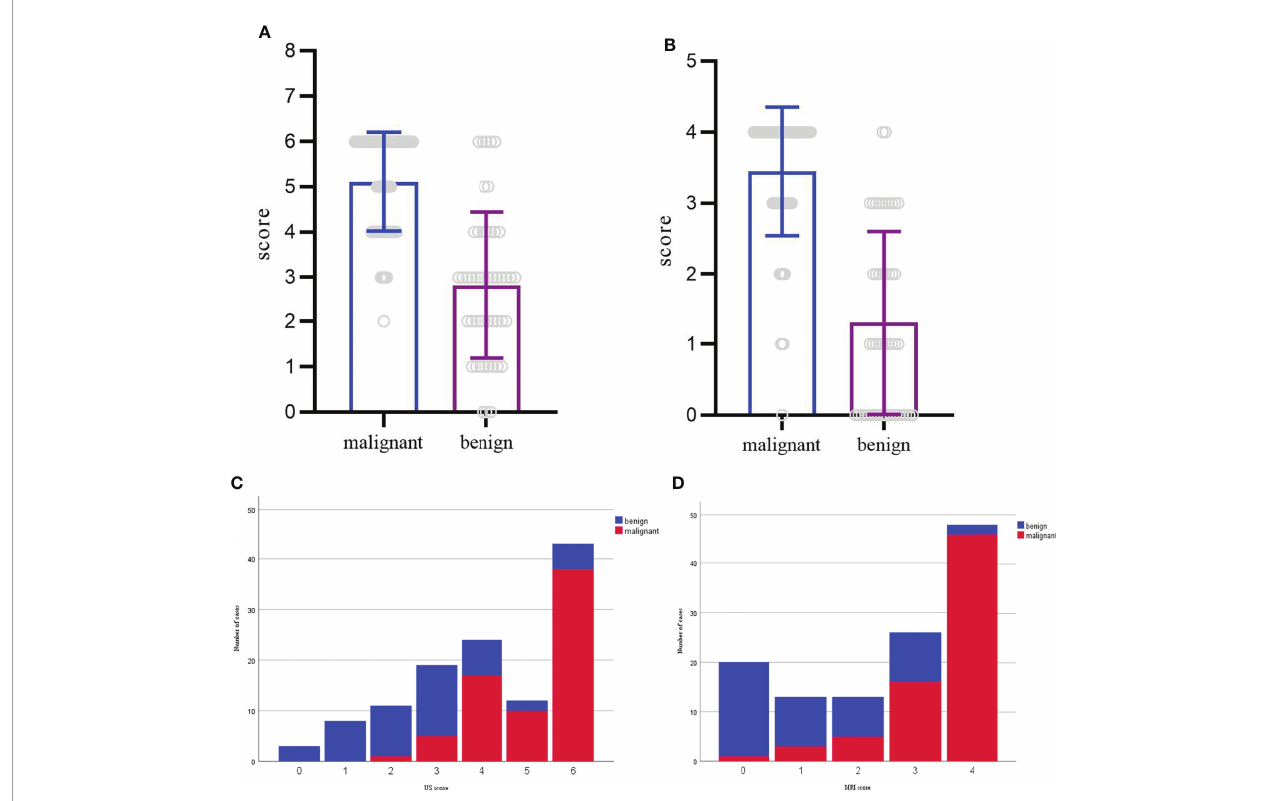
FIGURE 3 | (A, C) Distribution of benign and malignant cases according to the US scoring system. The score of each mass ranged from 0-6. (B, D) Distribution of benign and malignant cases according to the MRI scoring system. The score of each mass ranged from